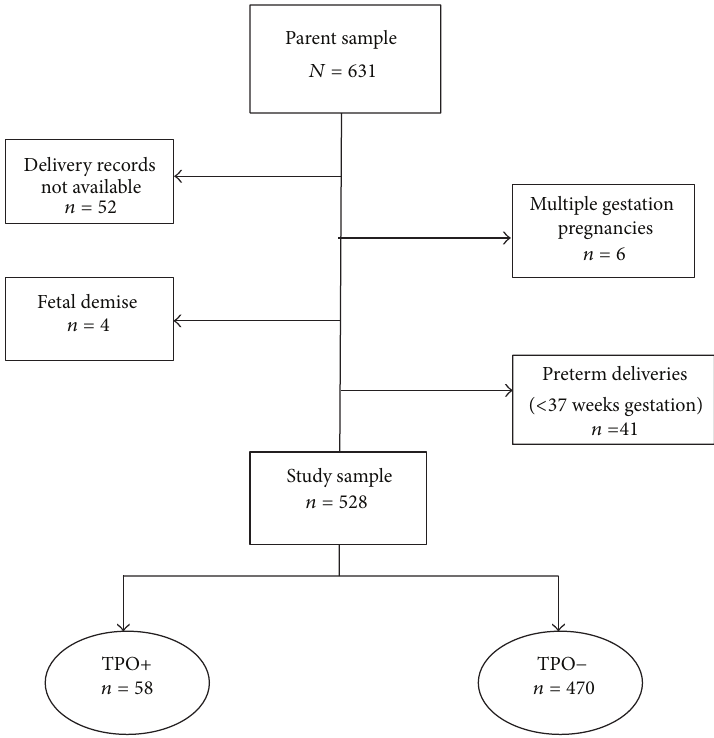
Figure 1: Diagram of study